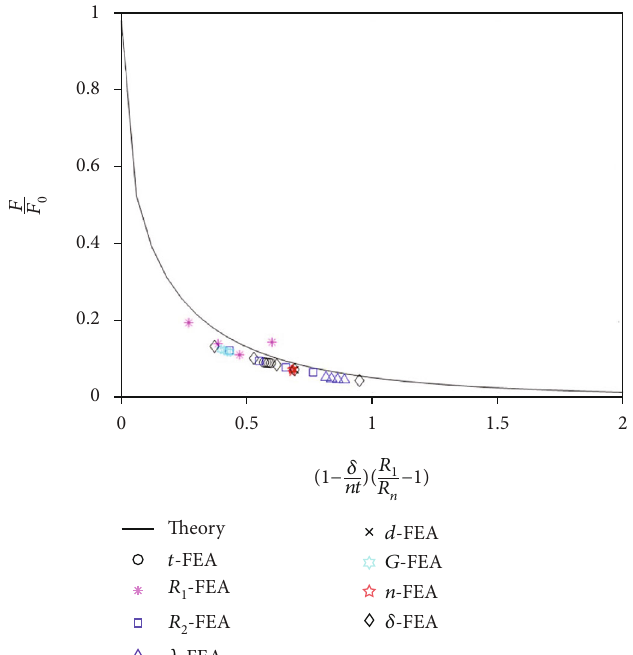
1 − δ / nt R 1 / ð Þð